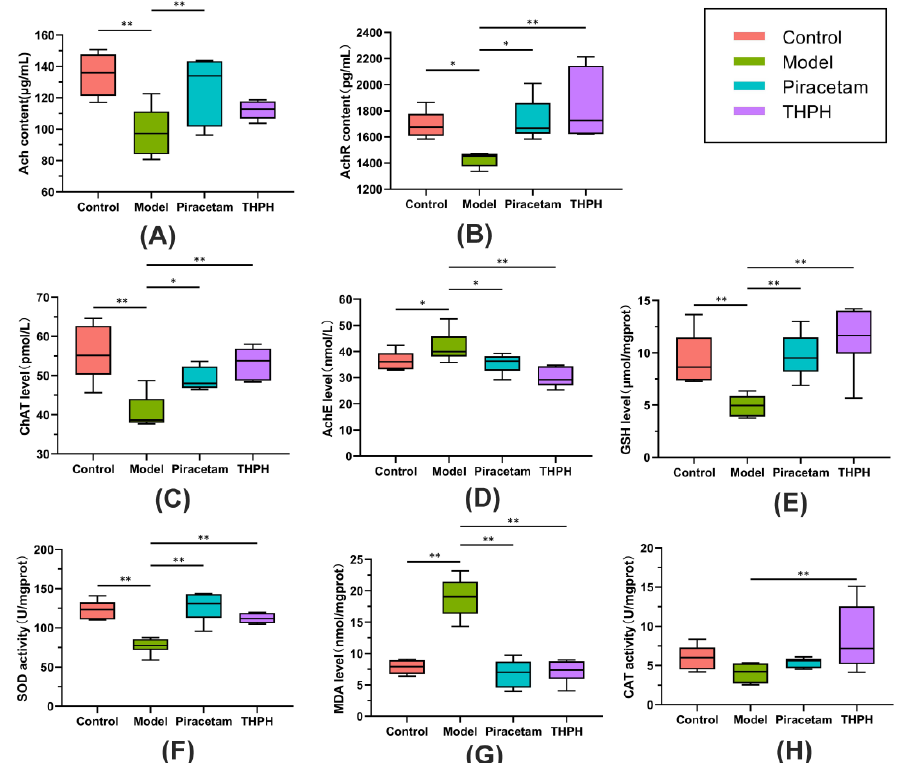
Figure 2. Effect of THPH on the cholinergic system and the oxidative stress in the brains of scopolamine-induced amnesia mice. Cholinergic system: ( A ) Level of Ach. ( B ) Level of AchR. ( C ) Level of ChAT. ( D ) Level of AchE. Oxidative stress: ( E ) Level of GSH. ( F ) Activity of SOD. ( G ) Level of MDA. ( H ) Activity of CAT. Data are presented as means ± SEM. * p < 0.05 indicates significant difference and ** p < 0.01 indicates extremely significant difference.